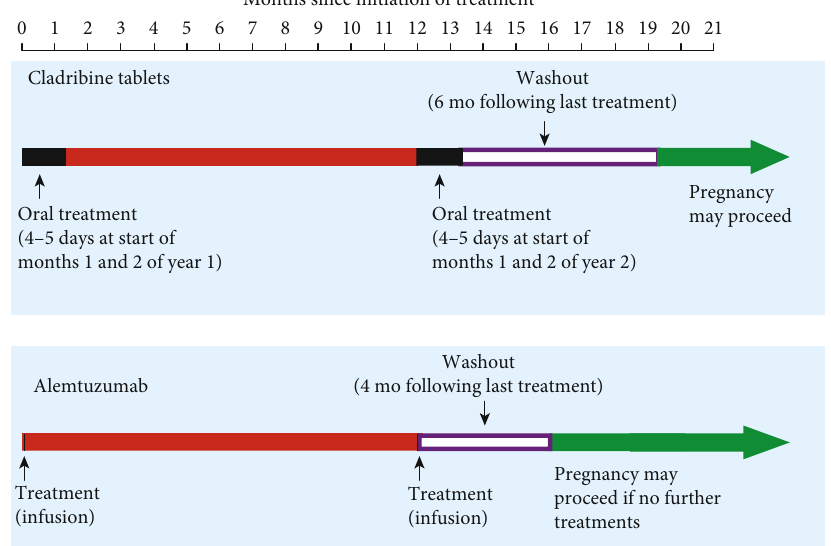
Figure 1: Schematic representation of the timings of treatment with disease-modifying drugs for MS that are hypothesised to act as immune reconstitution inhibitors, with regard to planning a pregnancy. Timings refer to the second year of a two-year course of treatment. If a patient becomes pregnant after only one course of treatment, the second course must be delayed until after the pregnancy (see